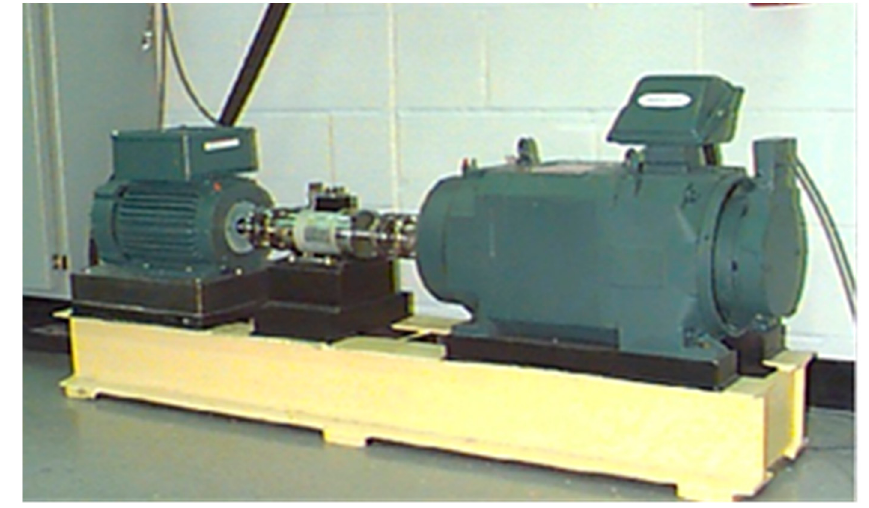
Figure 14. Test-rig of the rolling bearing.